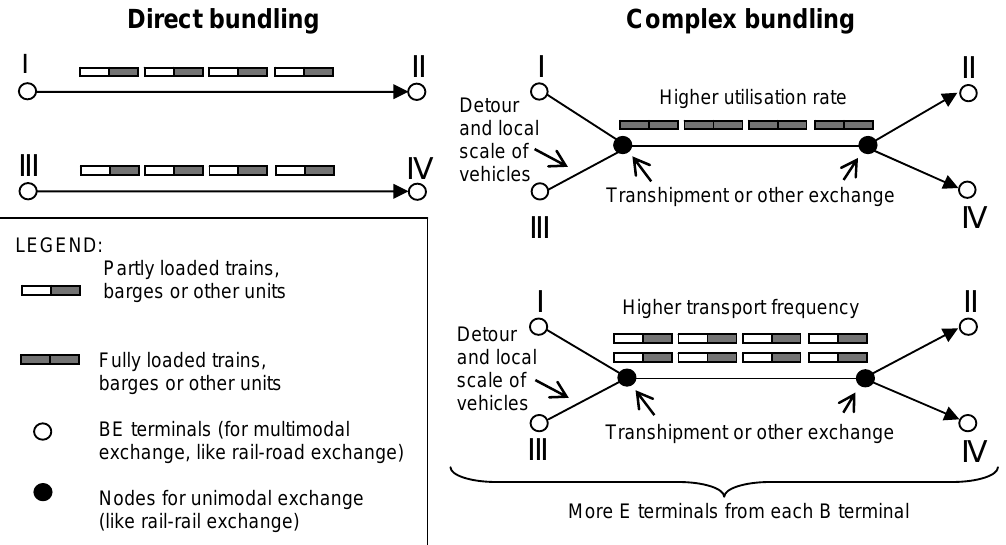
Figure 1. The principle and impacts of (complex) bundling Complex bundling also has disadvantages as (right side of Figure 1) longer routes (detour), longer operational time, in many cases additional exchange of load units at intermediate nodes, and in some cases local rail transport. The additional train distance, exchange handling and local transport imply higher costs, while the additional time of train operations can increase train and load unit